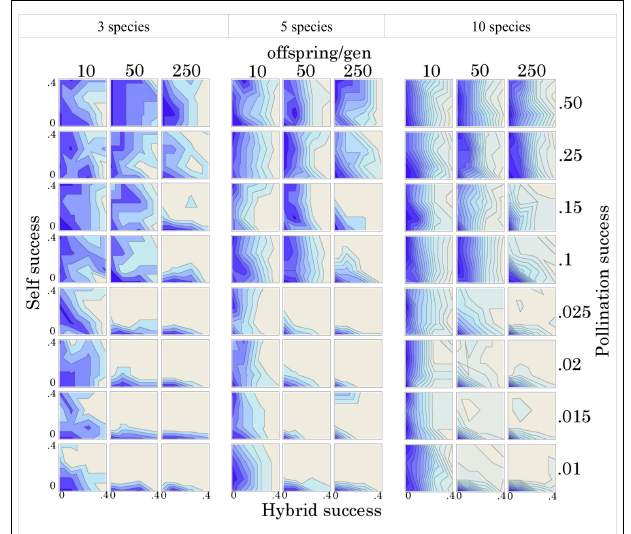
FIGURE 2 | Species richness after 500 reproductive events, given different levels of sympatry (3, 5, and 10 congeneric species), fecundity (10, 50, and 250 offspring/generation), pollination success (0.01, 0.015, 0.02, 0.025, 0.1, 0.15, 0.25, and 0.50), selfing success (0, 0.1, 0.25, and 0.4), and hybridization success (0, 0.1, 0.25, and 0.4). Each contour line represents 0.5 species and darker shades indicate lower species diversity. Contour lines in each graph are interpolated from selfing and hybridization success rates. See Methods and Supplemental Information for more